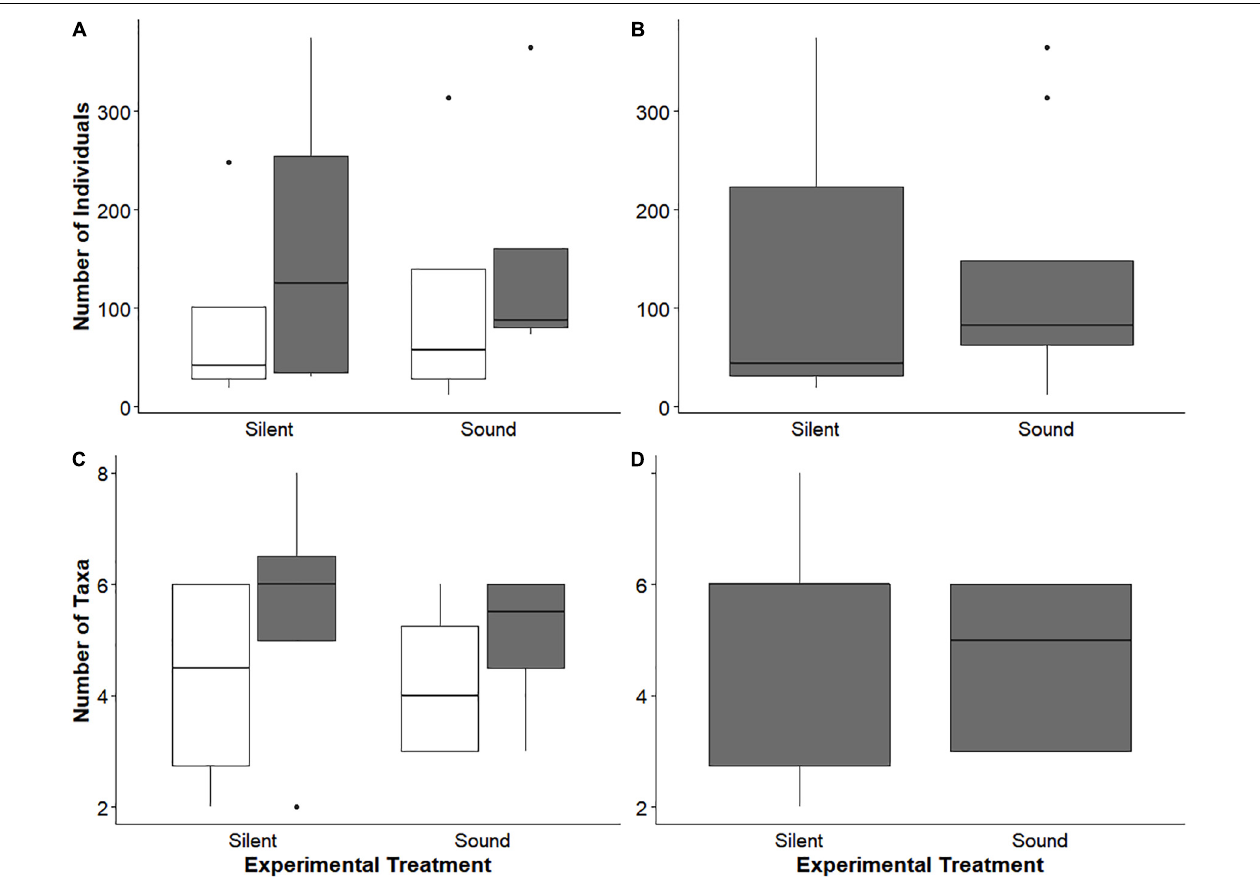
FIGURE 4 | Boxplots of larval collections during experimental sound playback. Number of larval fish and invertebrates (A) and number of larval fish and invertebrate taxa (C) that settled on larval shag collectors during full moon (light colors) or new moon (dark colors) at degraded hardbottom sites when the soundscape of healthy hardbottom was played (blue) versus a nearby site where no sound was played (silent control; red). Overall number of larval fish and invertebrates and number of taxa that settled into sound payback treatments and silent controls are shown in panels (B,D) ,